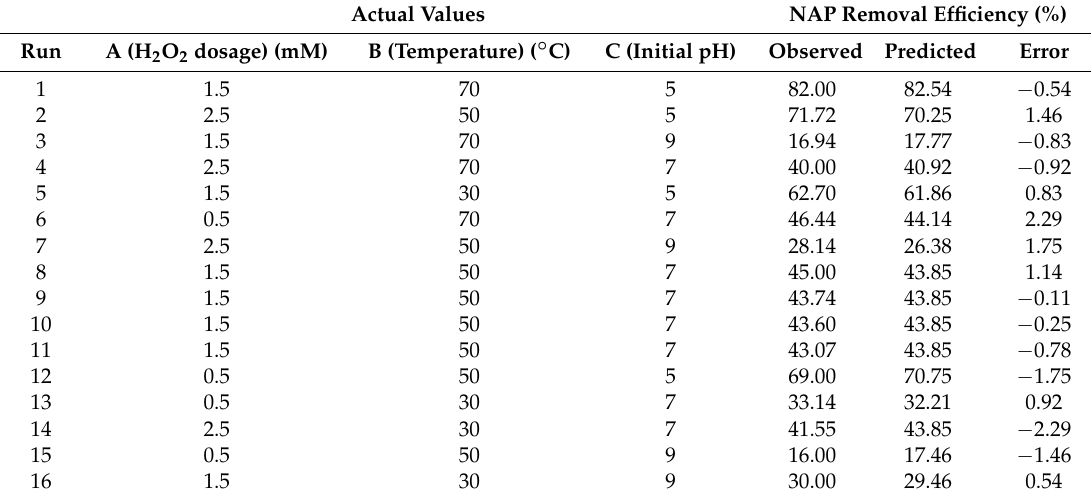
Table 3. Experimental design matrix of the degradation of naproxen (NAP) by catalytic wet peroxide oxidation (CWPO). Actual Values